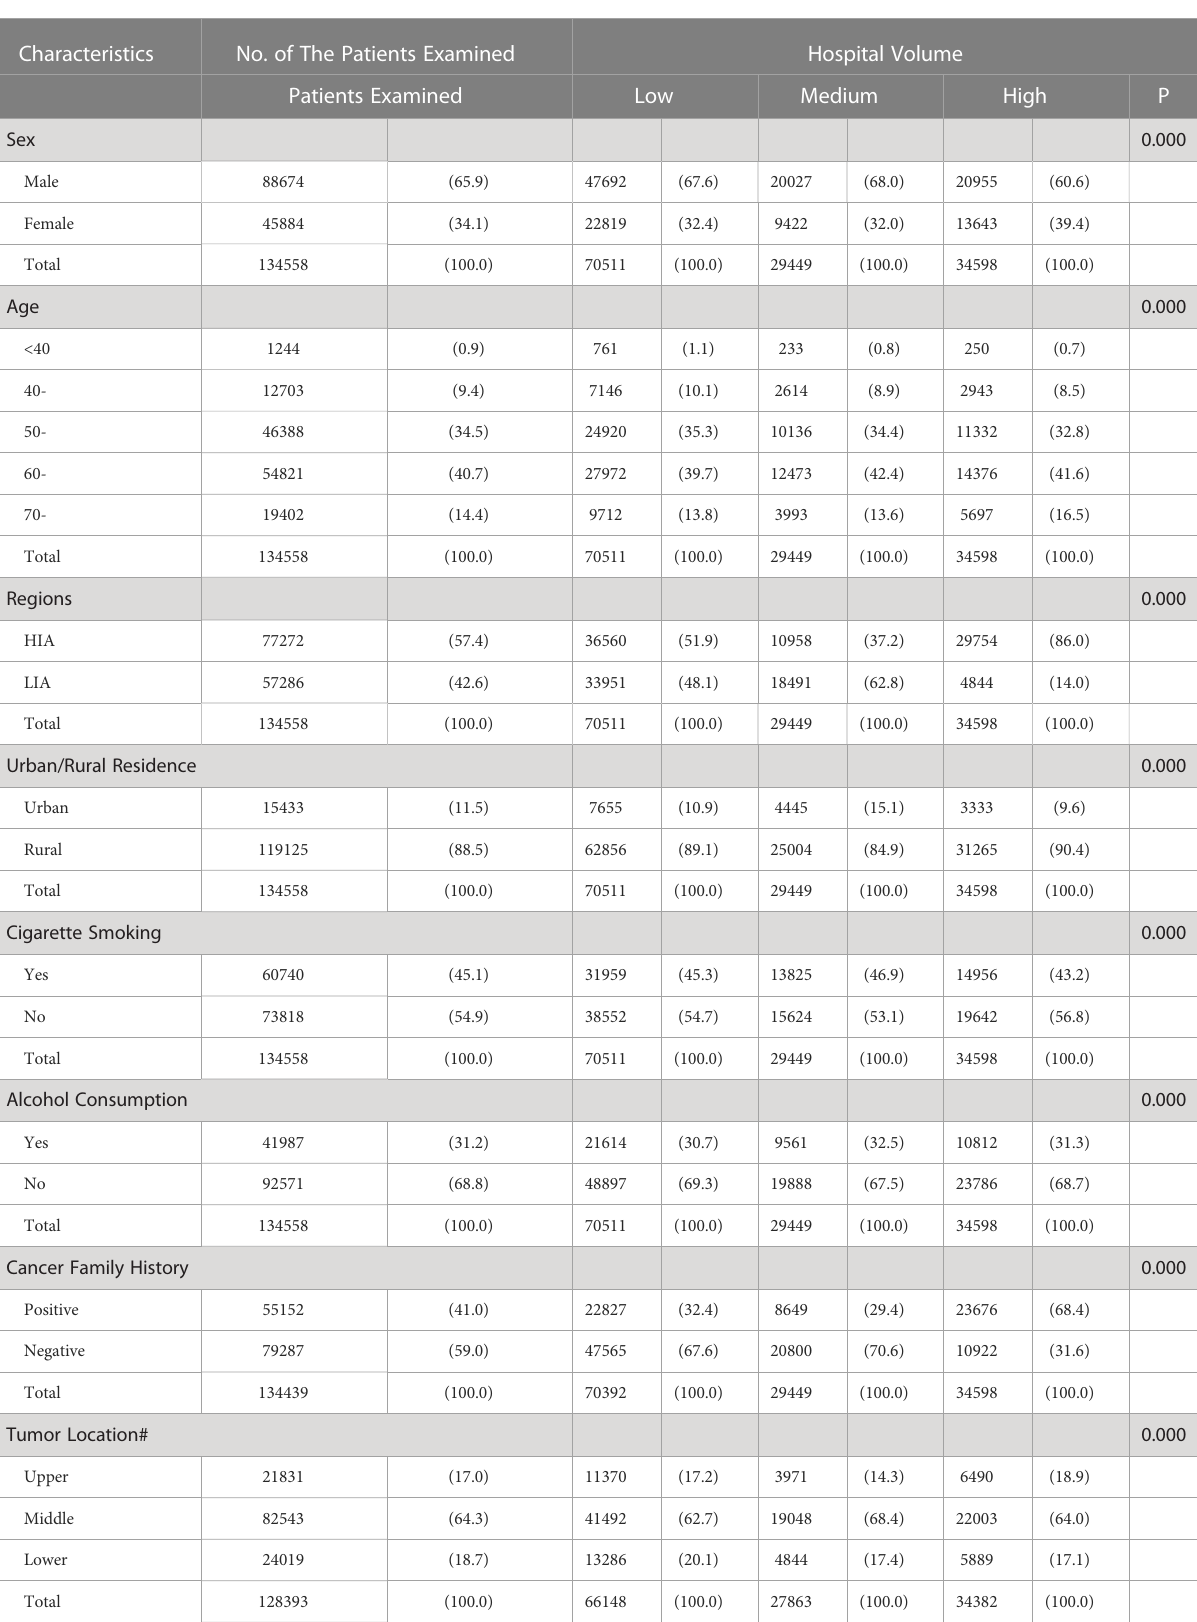
TABLE 2 Relationship between the clinicopathological features of ESCC patients and hospital volume during 1997-2020, n(%).